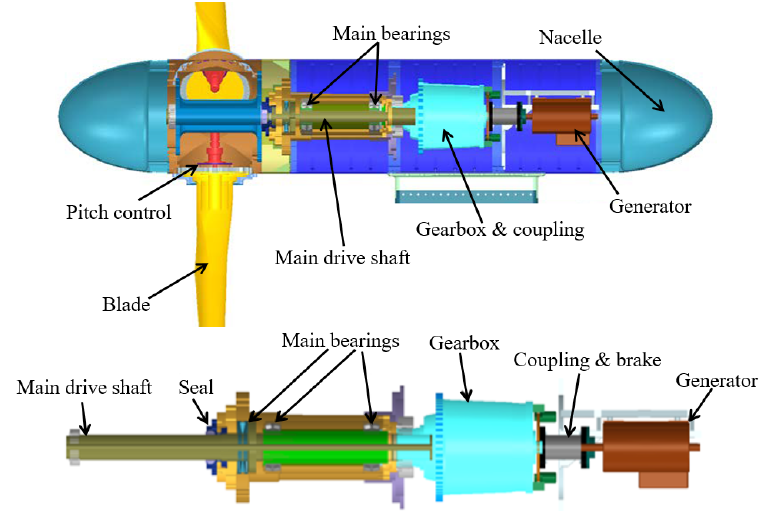
Figure 1. Schematic of a power conversion chain of the TCEC